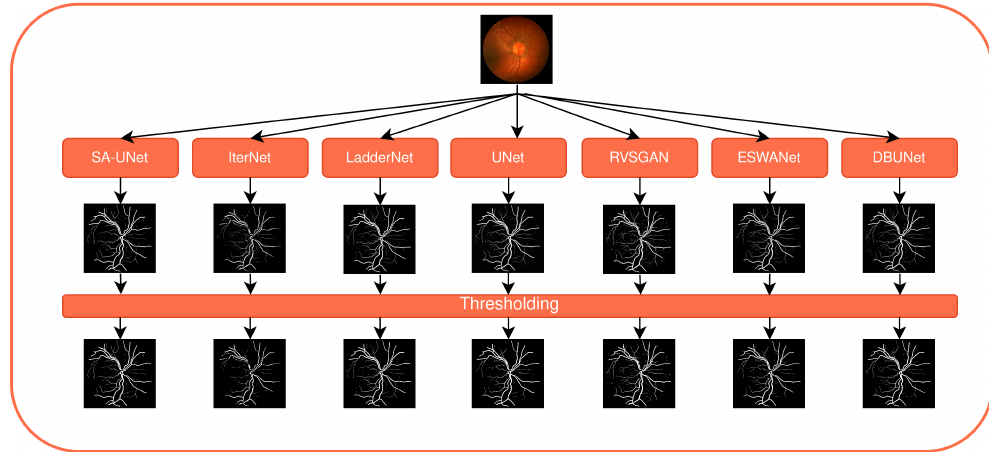
Figure 4. Experimental pipeline illustrating a pipeline to create segmentation masks used in the experiment from input fundus